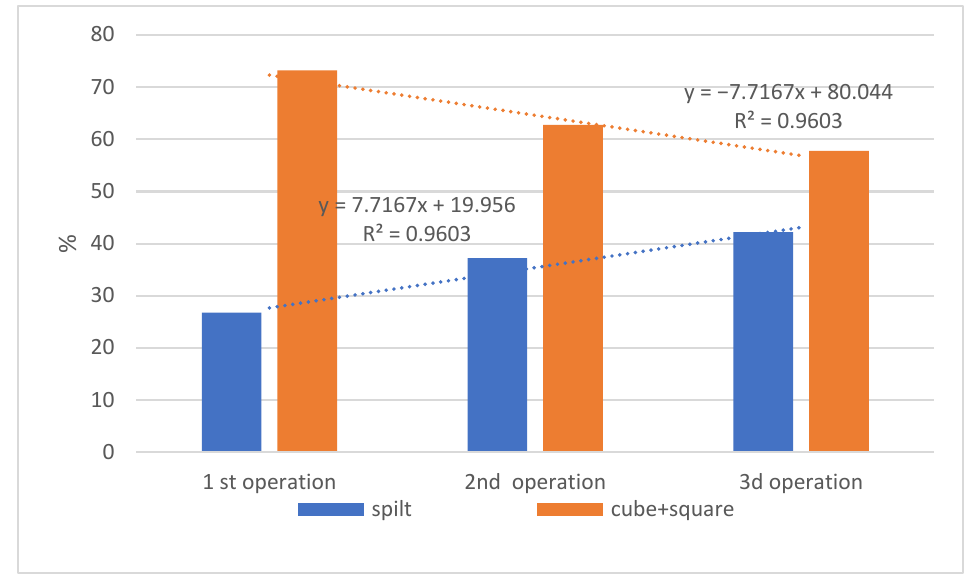
Figure 9. Experimental results: distribution comparison of cubic and square and spilt fragment forms based on the mean values for the three experiments. Approximating curve shows these changes.